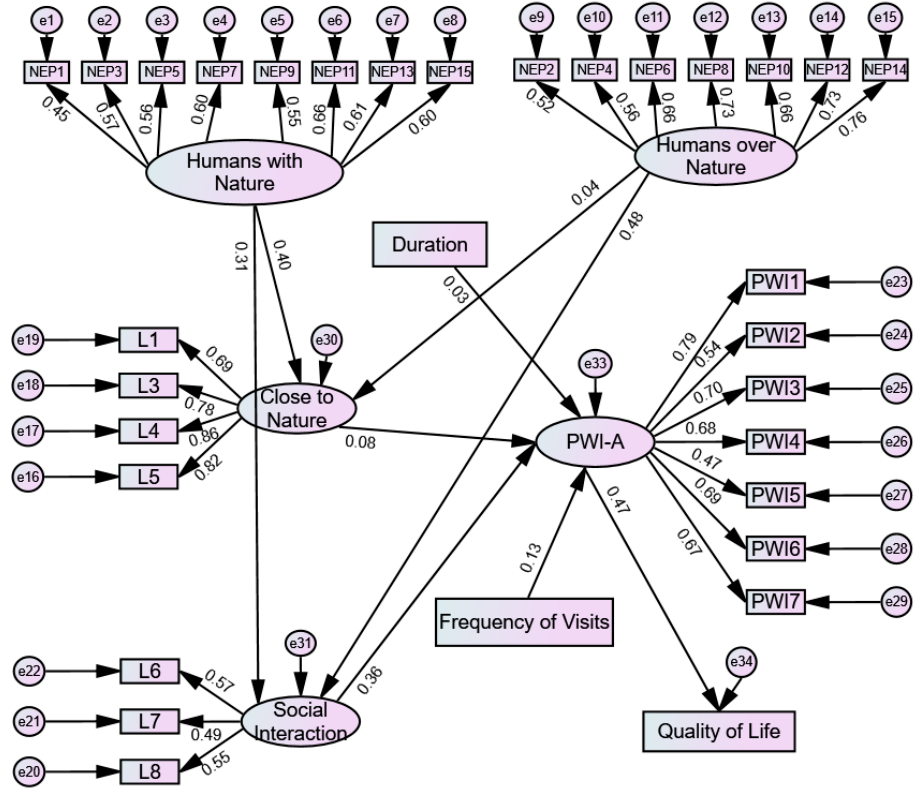
Figure 4. Structural equation model for the 2021 sample.